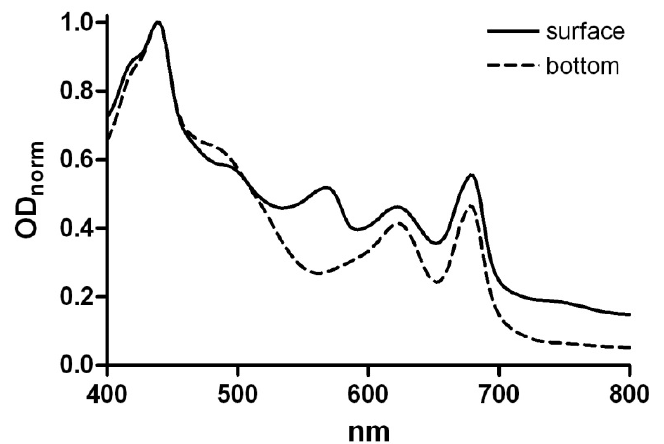
Figure 2. HPLC chromatogram of bioglea in toto . The peak with interesting UV absorption at 300 nm was highlighted.